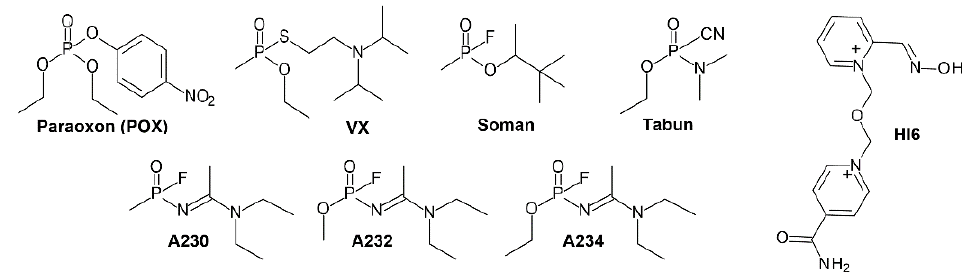
Figure 1. Structures of OPs and an oxime antidote HI6 used in this study. Paraoxon is an active form of the OP pesticide parathion. VX, Soman and Tabun are “classical” nerve agent OPs and A230, A232 and A234 are Novichok nerve agent OPs.